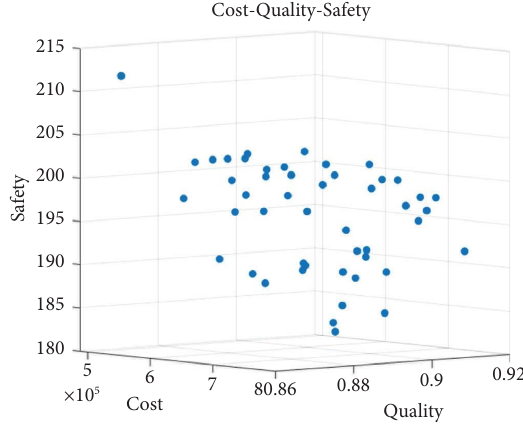
Figure 12: Cost-quality-safety trade-of.